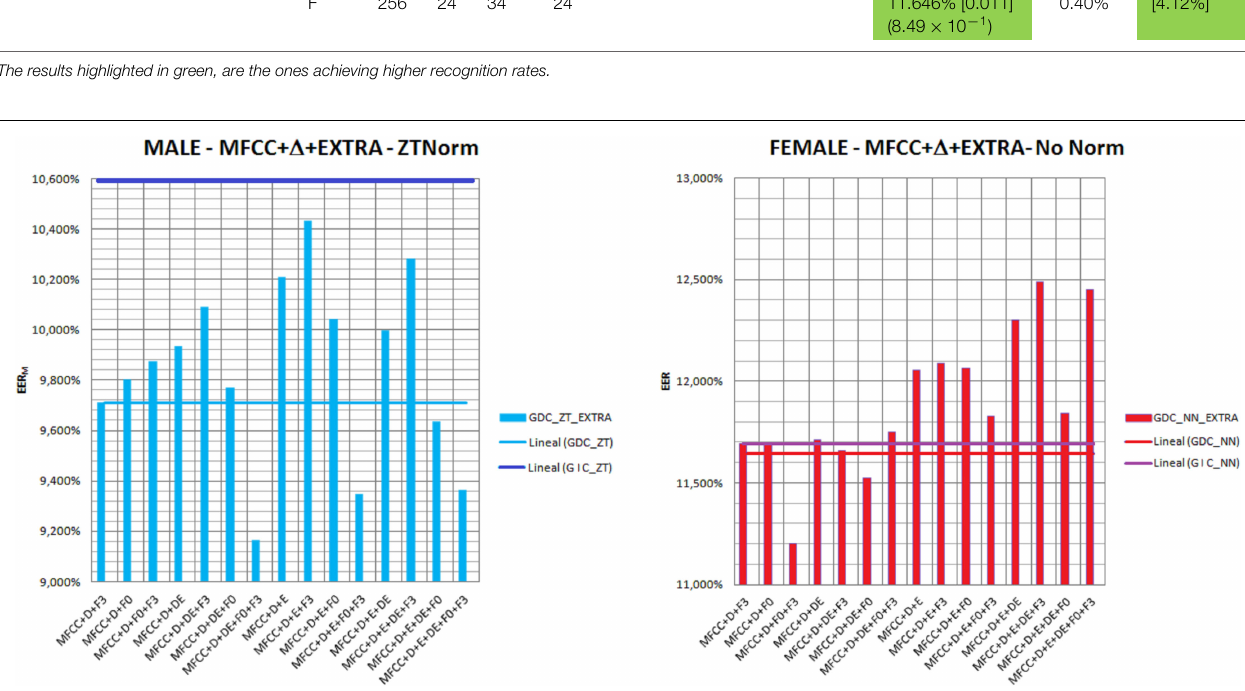
FIGURE 9 | EER achieved for male and female speakers, when ZTNorm in the case of male (left) and NoNorm in the case of female (right) speakers are applied, in a gender-dependent setup which incorporates different combinations of extra parameters .